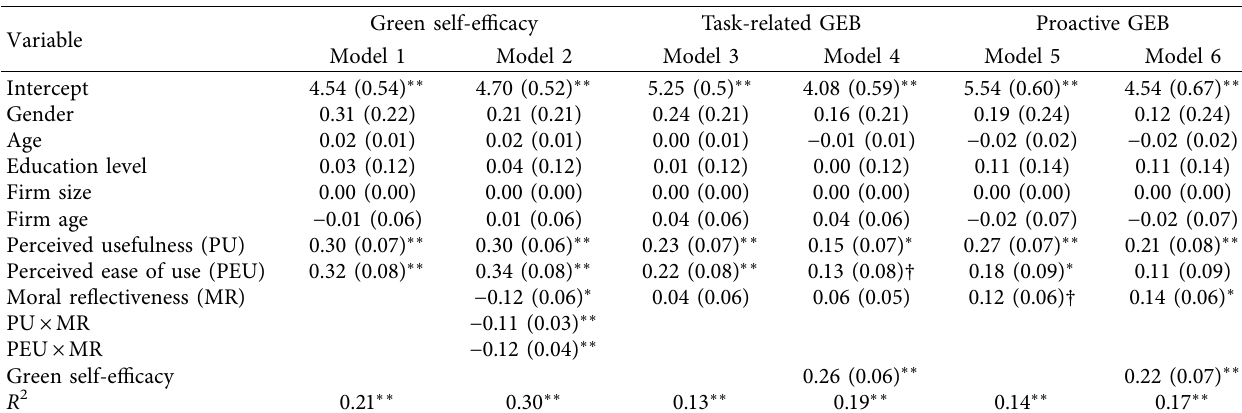
Table 2: Hierarchical regression